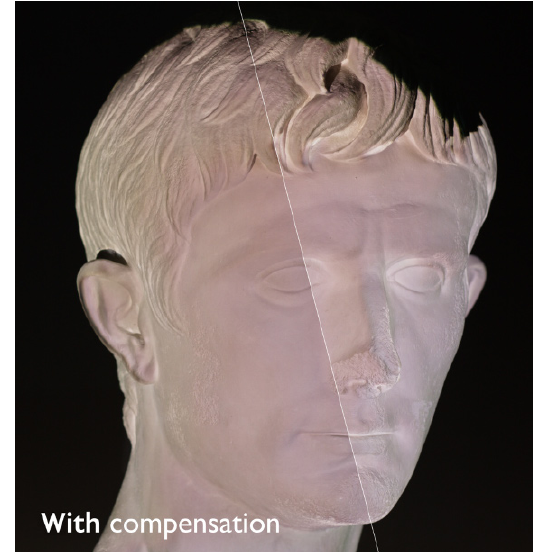
Fig. 8 Results of interreflection correction. Note the more even luminance